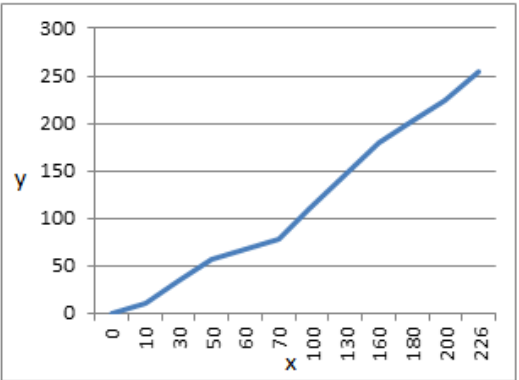
Figure 4. Linear Contrast Stretching for 𝑦 = 1.128𝑥